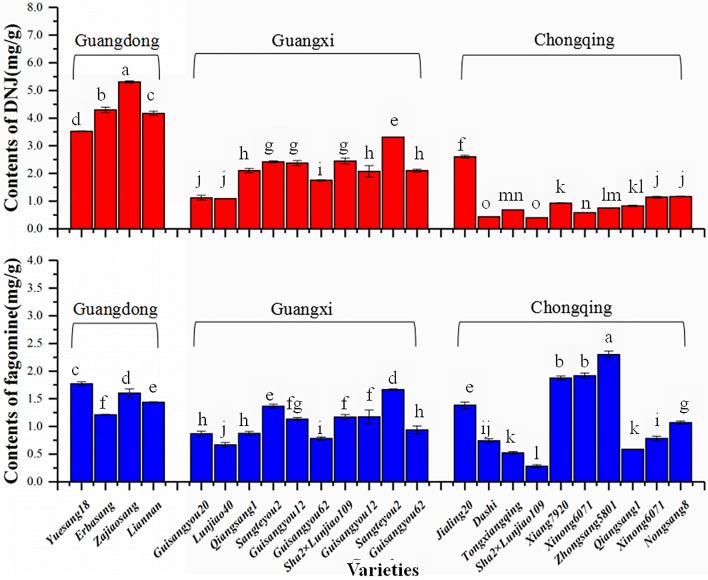
Contents of DNJ and fagomine from different collection areas.(TIF) The red columns mean the contents of DNJ from different collection areas and the blue columns mean the contents of fagomine.